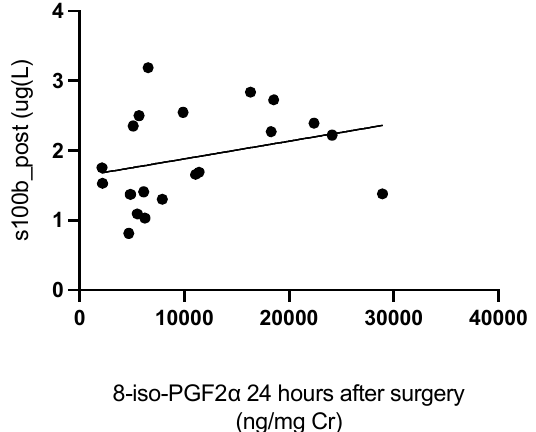
Figure 4. Correlation between levels of S100B immediately post-surgery and levels of 8-iso-PGF2 α 24 h after surgery.